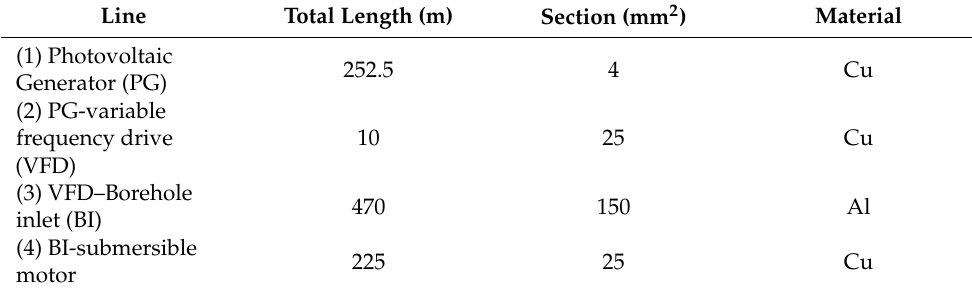
Table 2. Lines of